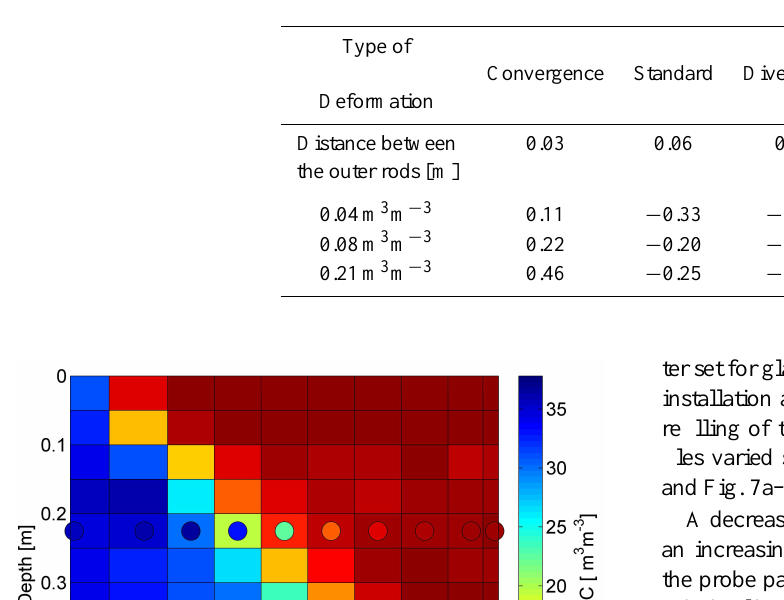
Table 6. Amplitude coefficient (CA) for different probe deformations at soil moisture of approximately 0.04m 3 m − 3 , 0.08m 3 m − 3 and 0.20m 3 m − 3 .